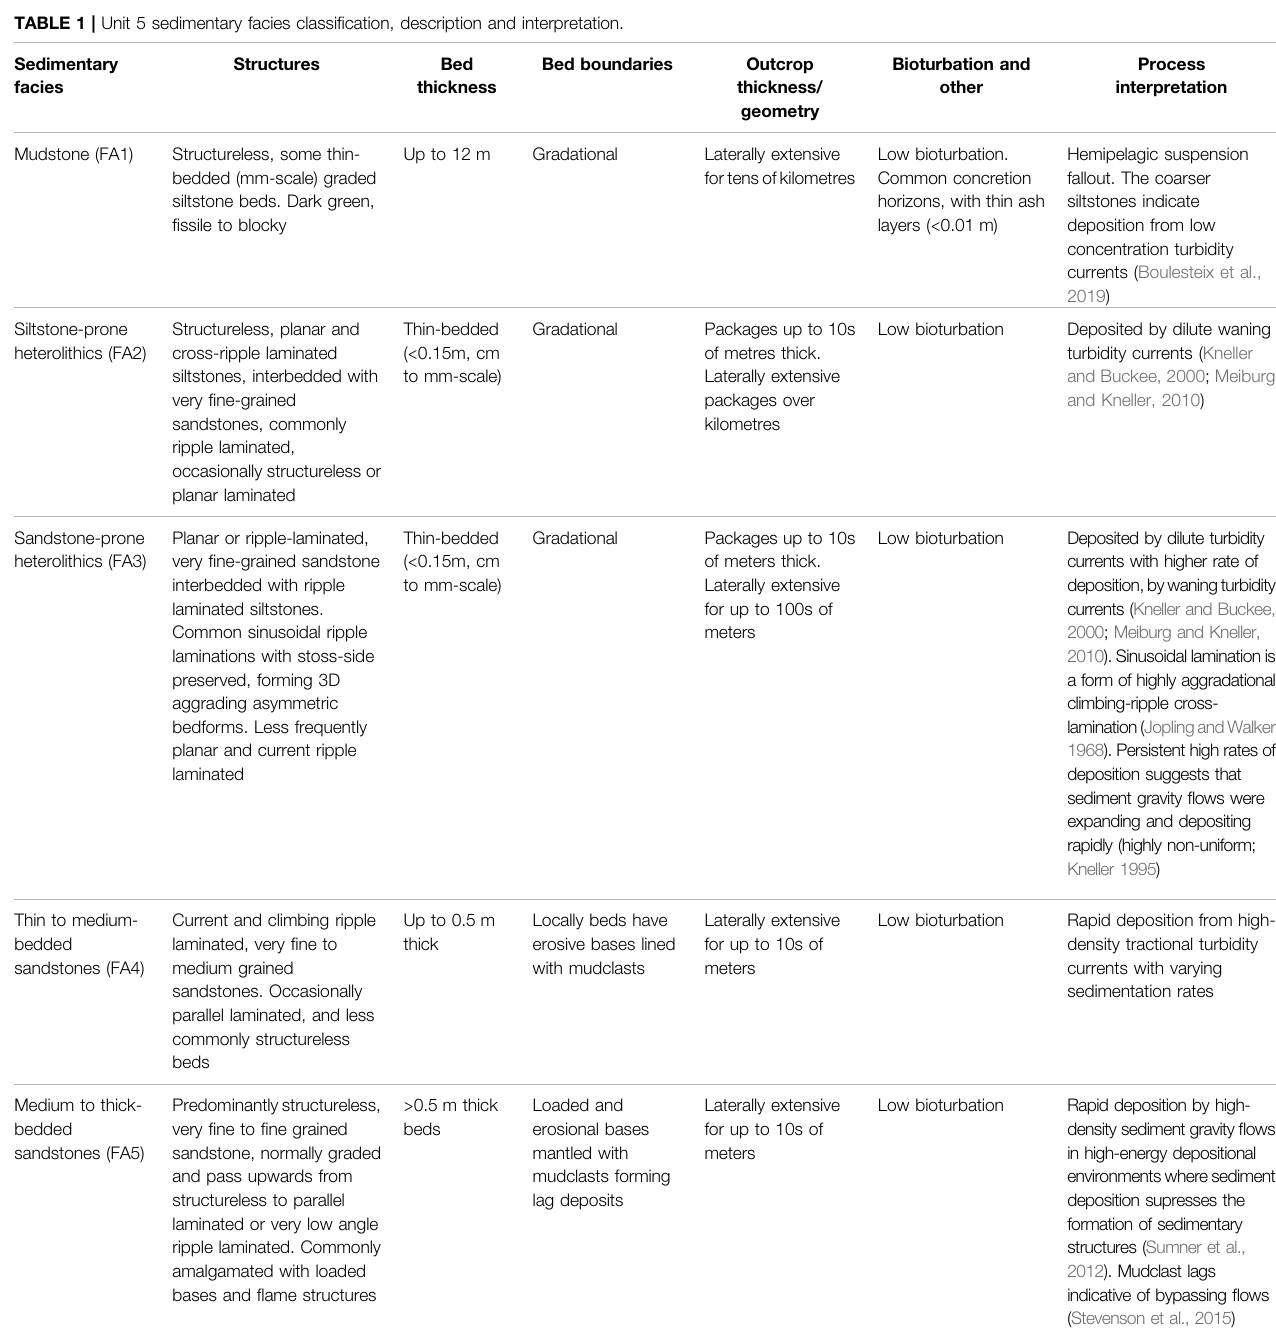
TABLE 1 | Unit 5 sedimentary facies classi fi cation, description and interpretation. Sedimentary